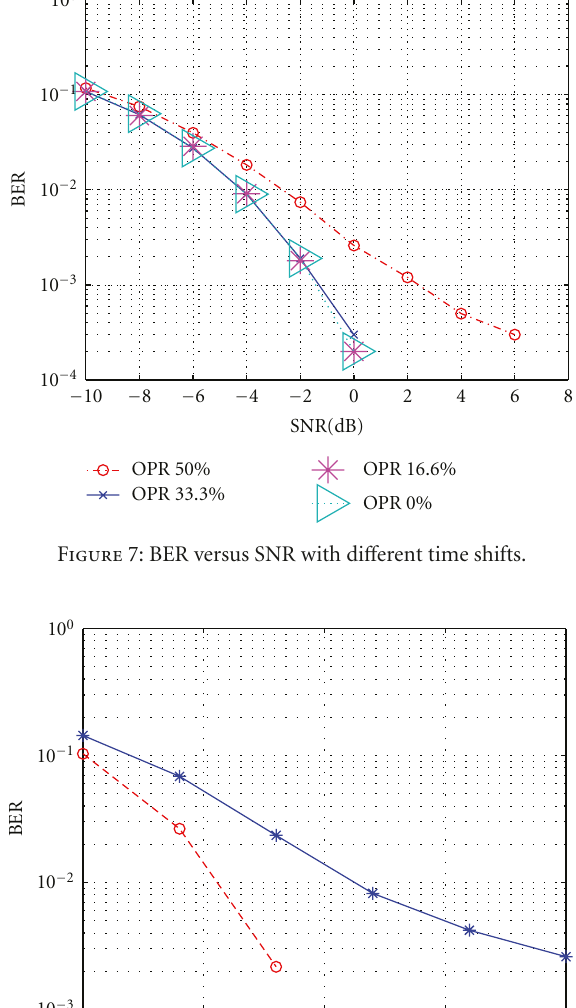
the BER versus SNR curves for di ff erent orders of Hermite- Gaussian signals. Each Hermite-Gaussian signal’s SNR versus BER performance is approximately equal to other